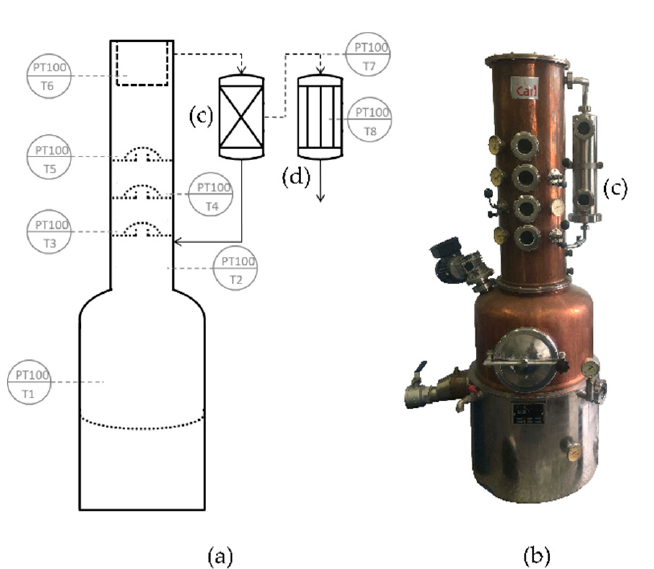
Figure 2. Instrumentation diagram ( a ) and front view ( b ) of distillation column with copper catalyzer ( c ) and vapor cooler ( d ), temperature sensors T1 = mash, T2 = below tray I, T3 = tray I, T4 = tray II, T5 = tray III, T6 = dephlegmator, T7 = vapor pipe, T8 = cooling water.